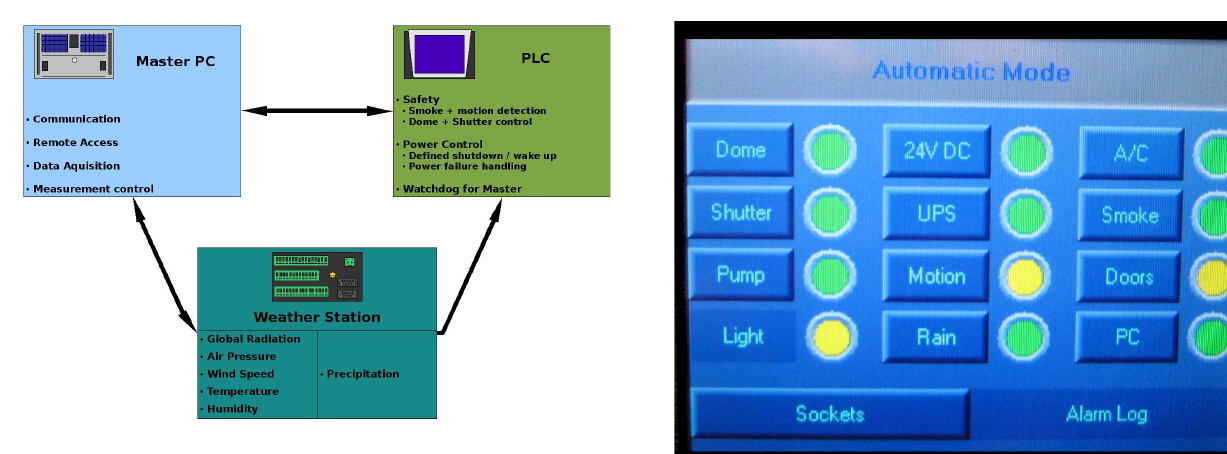
Fig. 7. Schematic overview of the communication. The three major parts of the FTIR system are autonomous systems. They communi- cate over a serial and an ethernet connection, repectively. Fig. 8. PLC control panel showing the PLC operating in automatic mode. It shows the actual container status, the colored bullets in- dicate status of each component – whereas green stands for “OK“, yellow for “in progress“ and red indicates ”alert“. Detailed infor- mation can be accessed via the sub